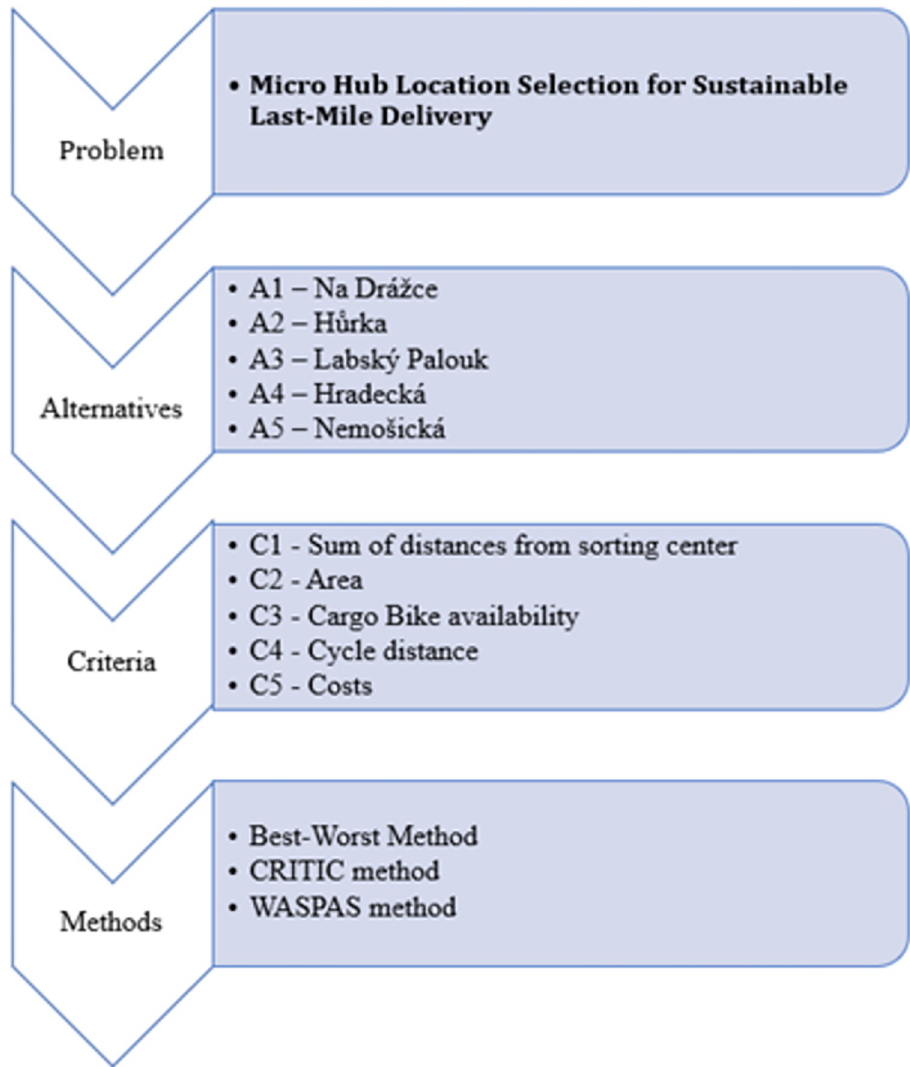
Fig 1. A flowchart of the micro-hub location